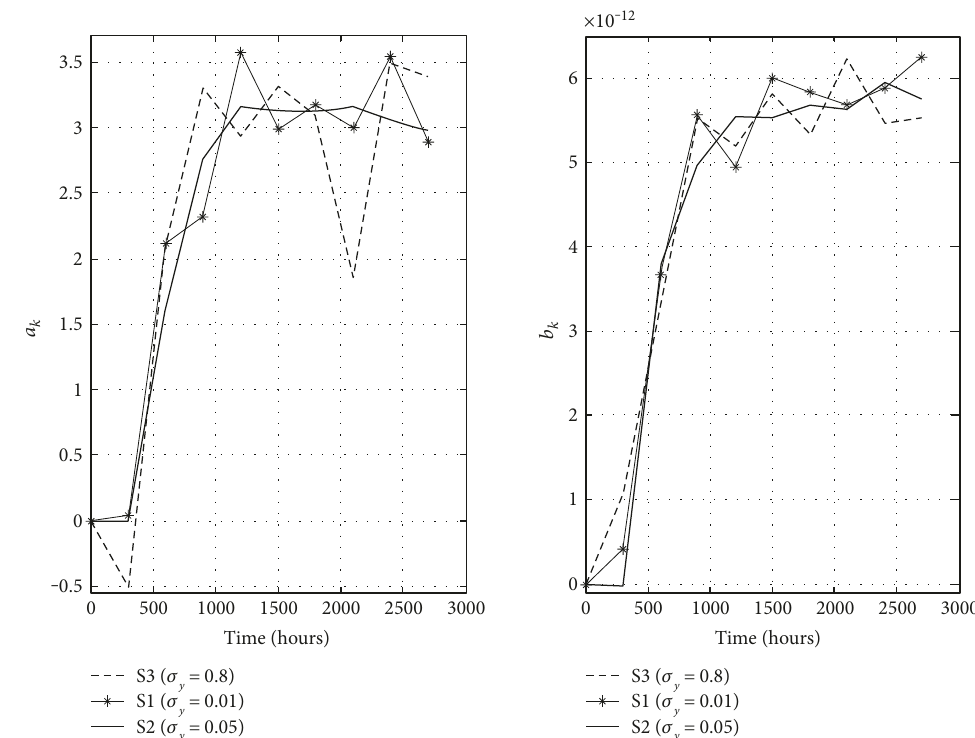
Figure 4: The uncertainty in fl uence on the parameter